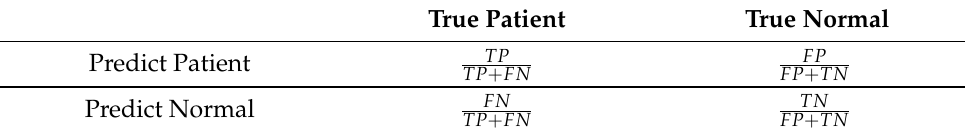
Table 2. Confusion matrix.